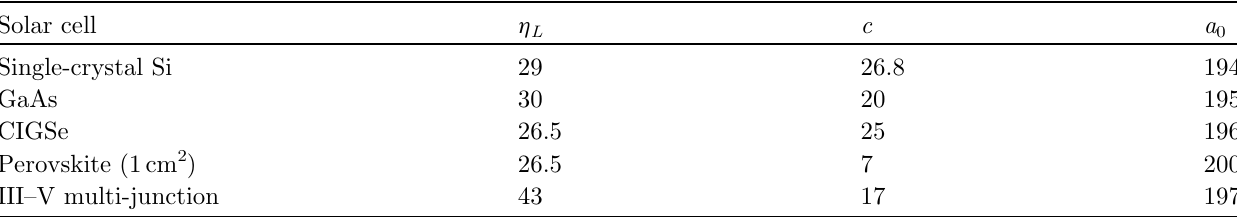
Table 1. Fitting parameters for different